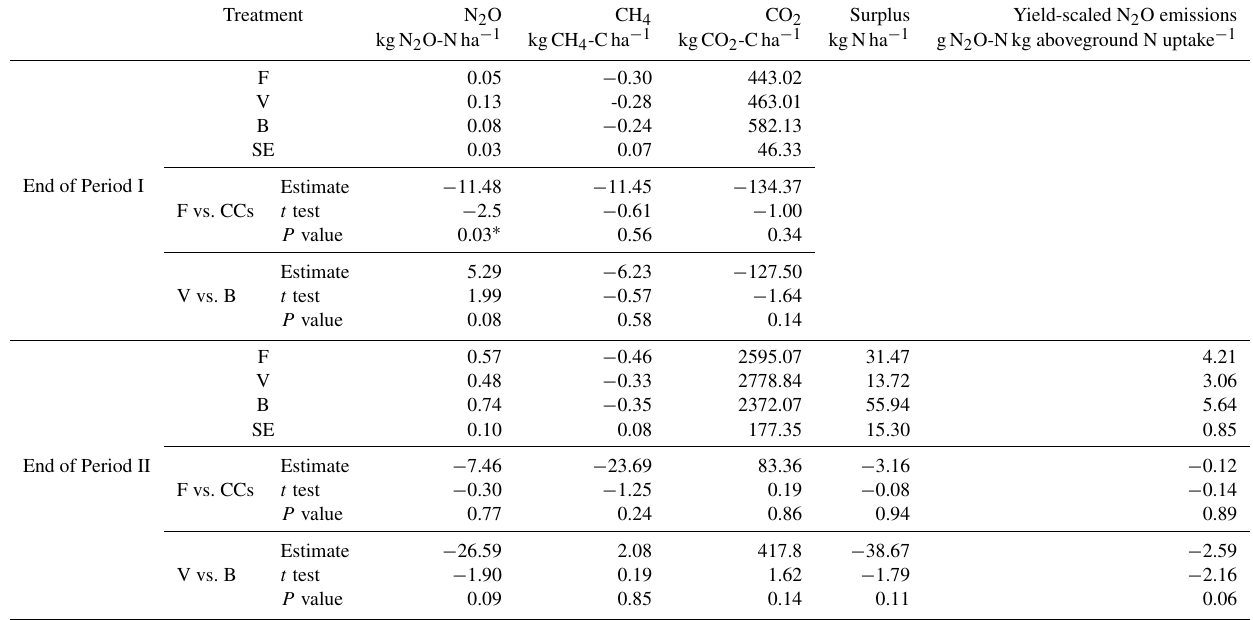
Table 1. Total cumulative N 2 O-N, CH 4 -C and CO 2 -C fluxes; N surplus; and yield-scaled N 2 O emissions in the three CC treatments (fallow, F; vetch, V; and barley, B) at the end of both cropping periods. P values were calculated with Student’s t test and df = 9. Treatment N 2 O CH 4 CO 2